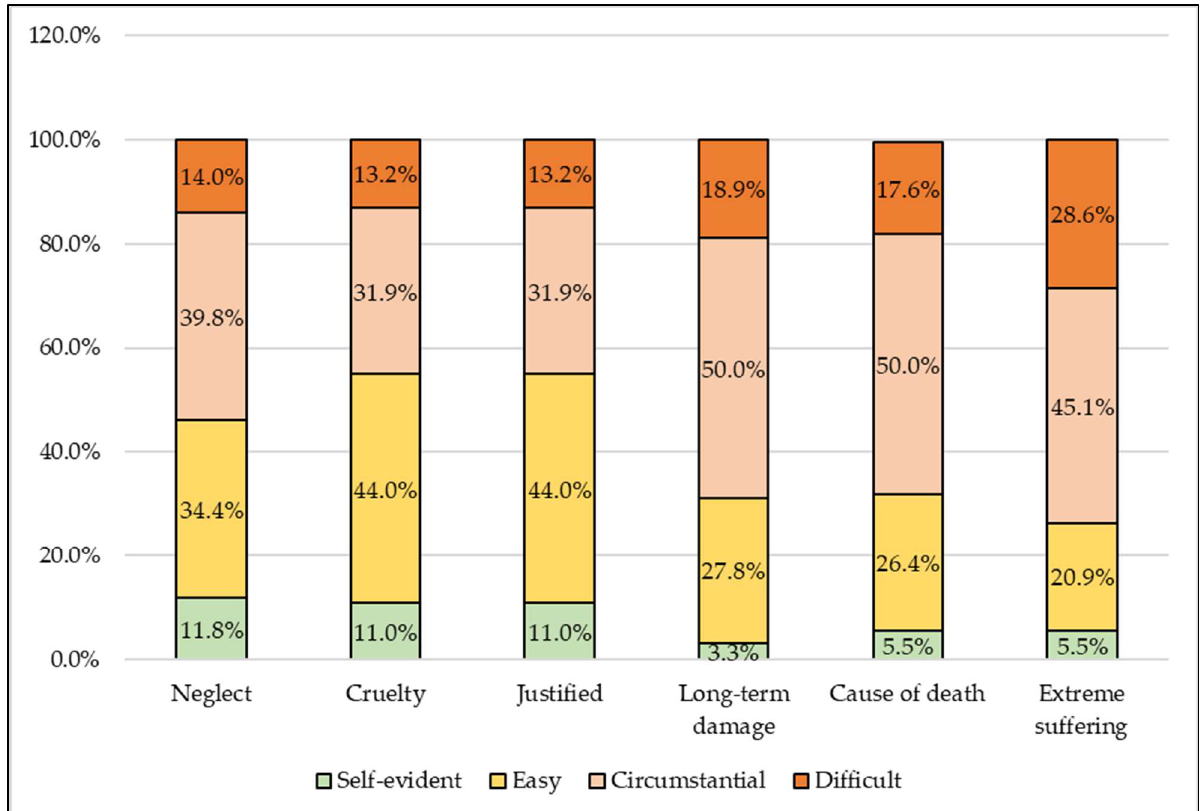
Figure 4. Which form of animal cruelty is more difficult to investigate?